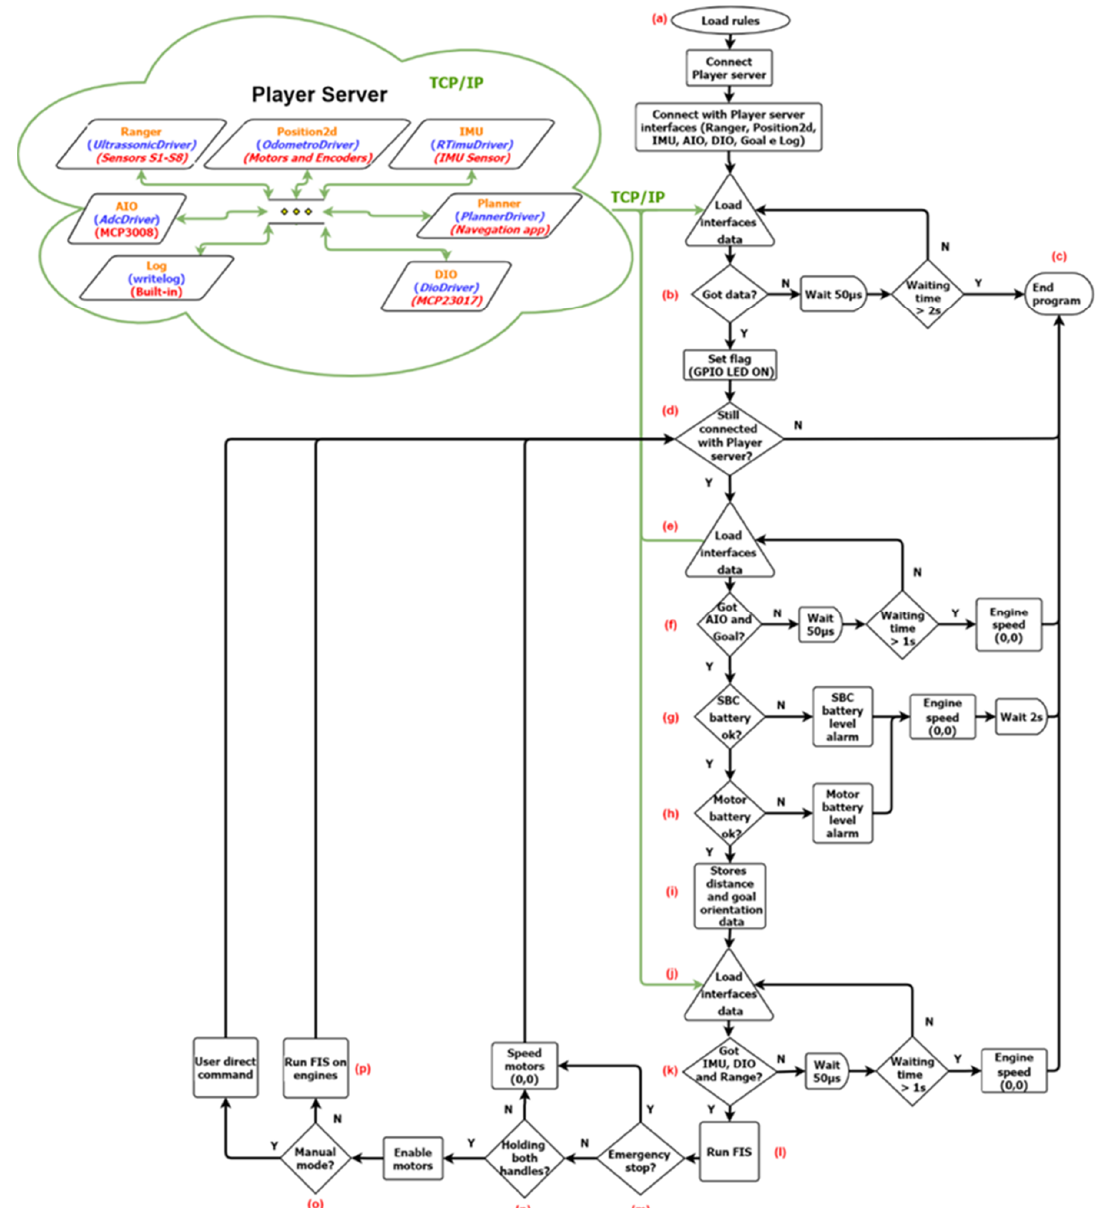
Figure 12. Flowchart of the main client program.